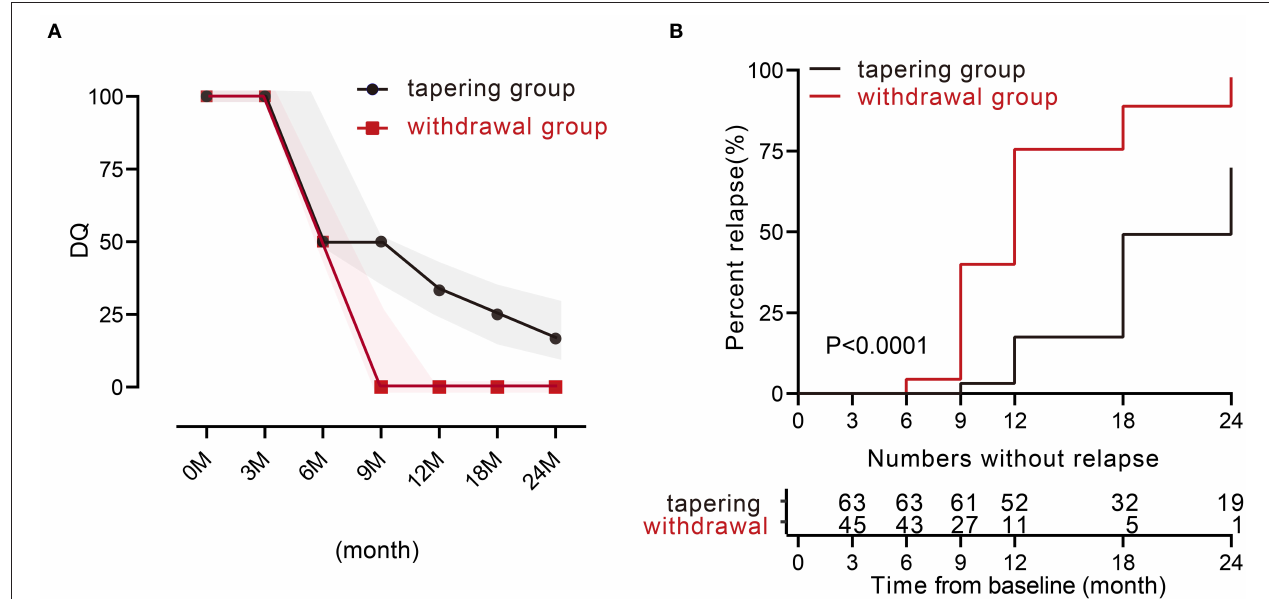
FIGURE 1 | TNFi levels and characteristics of relapse during 24 months between the two groups. (A) Medians of dose quotient in the two groups during the 24 months. The shadow represents the interquartile range. (B) Relapse rate during the 24 months between the two groups ( p < 0.0001). TNFi, tumor necrosis factor